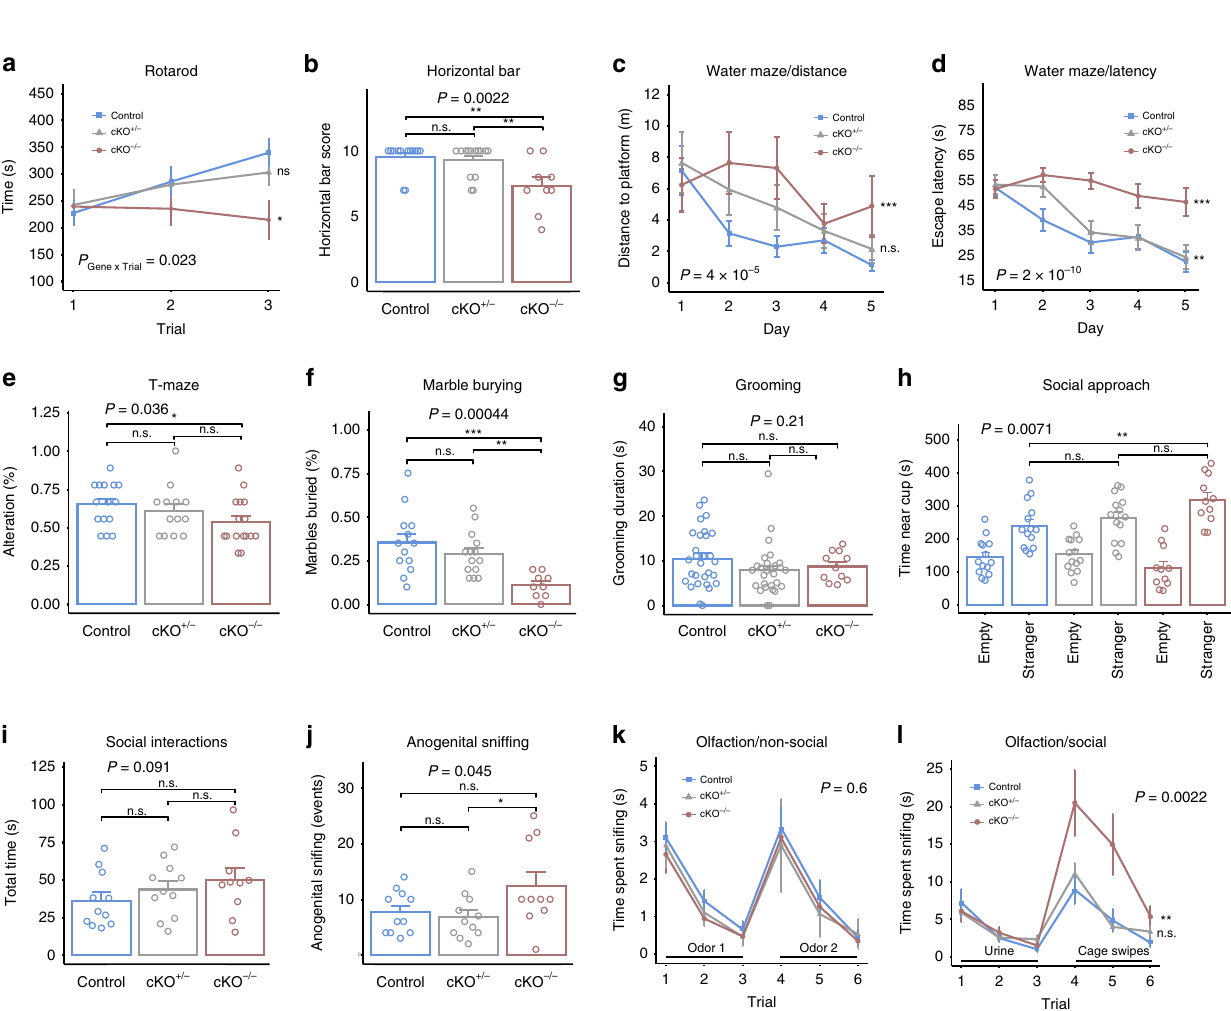
( P = 0.13) (Supplementary Fig. S4h), whereas nose-to-anogenital snif fi ng was signi fi cantly increased ( P = 0.045) (Fig. 3j). To test if